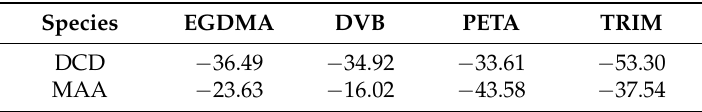
Table 3. Binding energies ( Δ E B2 ) between DCD as well as MAA and different cross-linkers at the